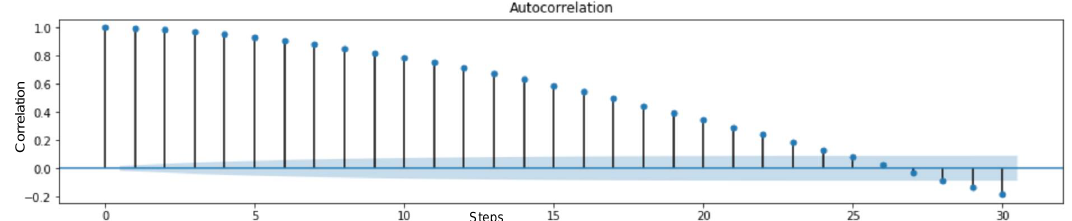
Figure 5. Graphics showing for every time step the degree of auto-correlation in the data from t 0 to t 30 which appear to be strong up to 18 steps. The gray area shows the uncertainty on the degree of auto-correlation, which remains